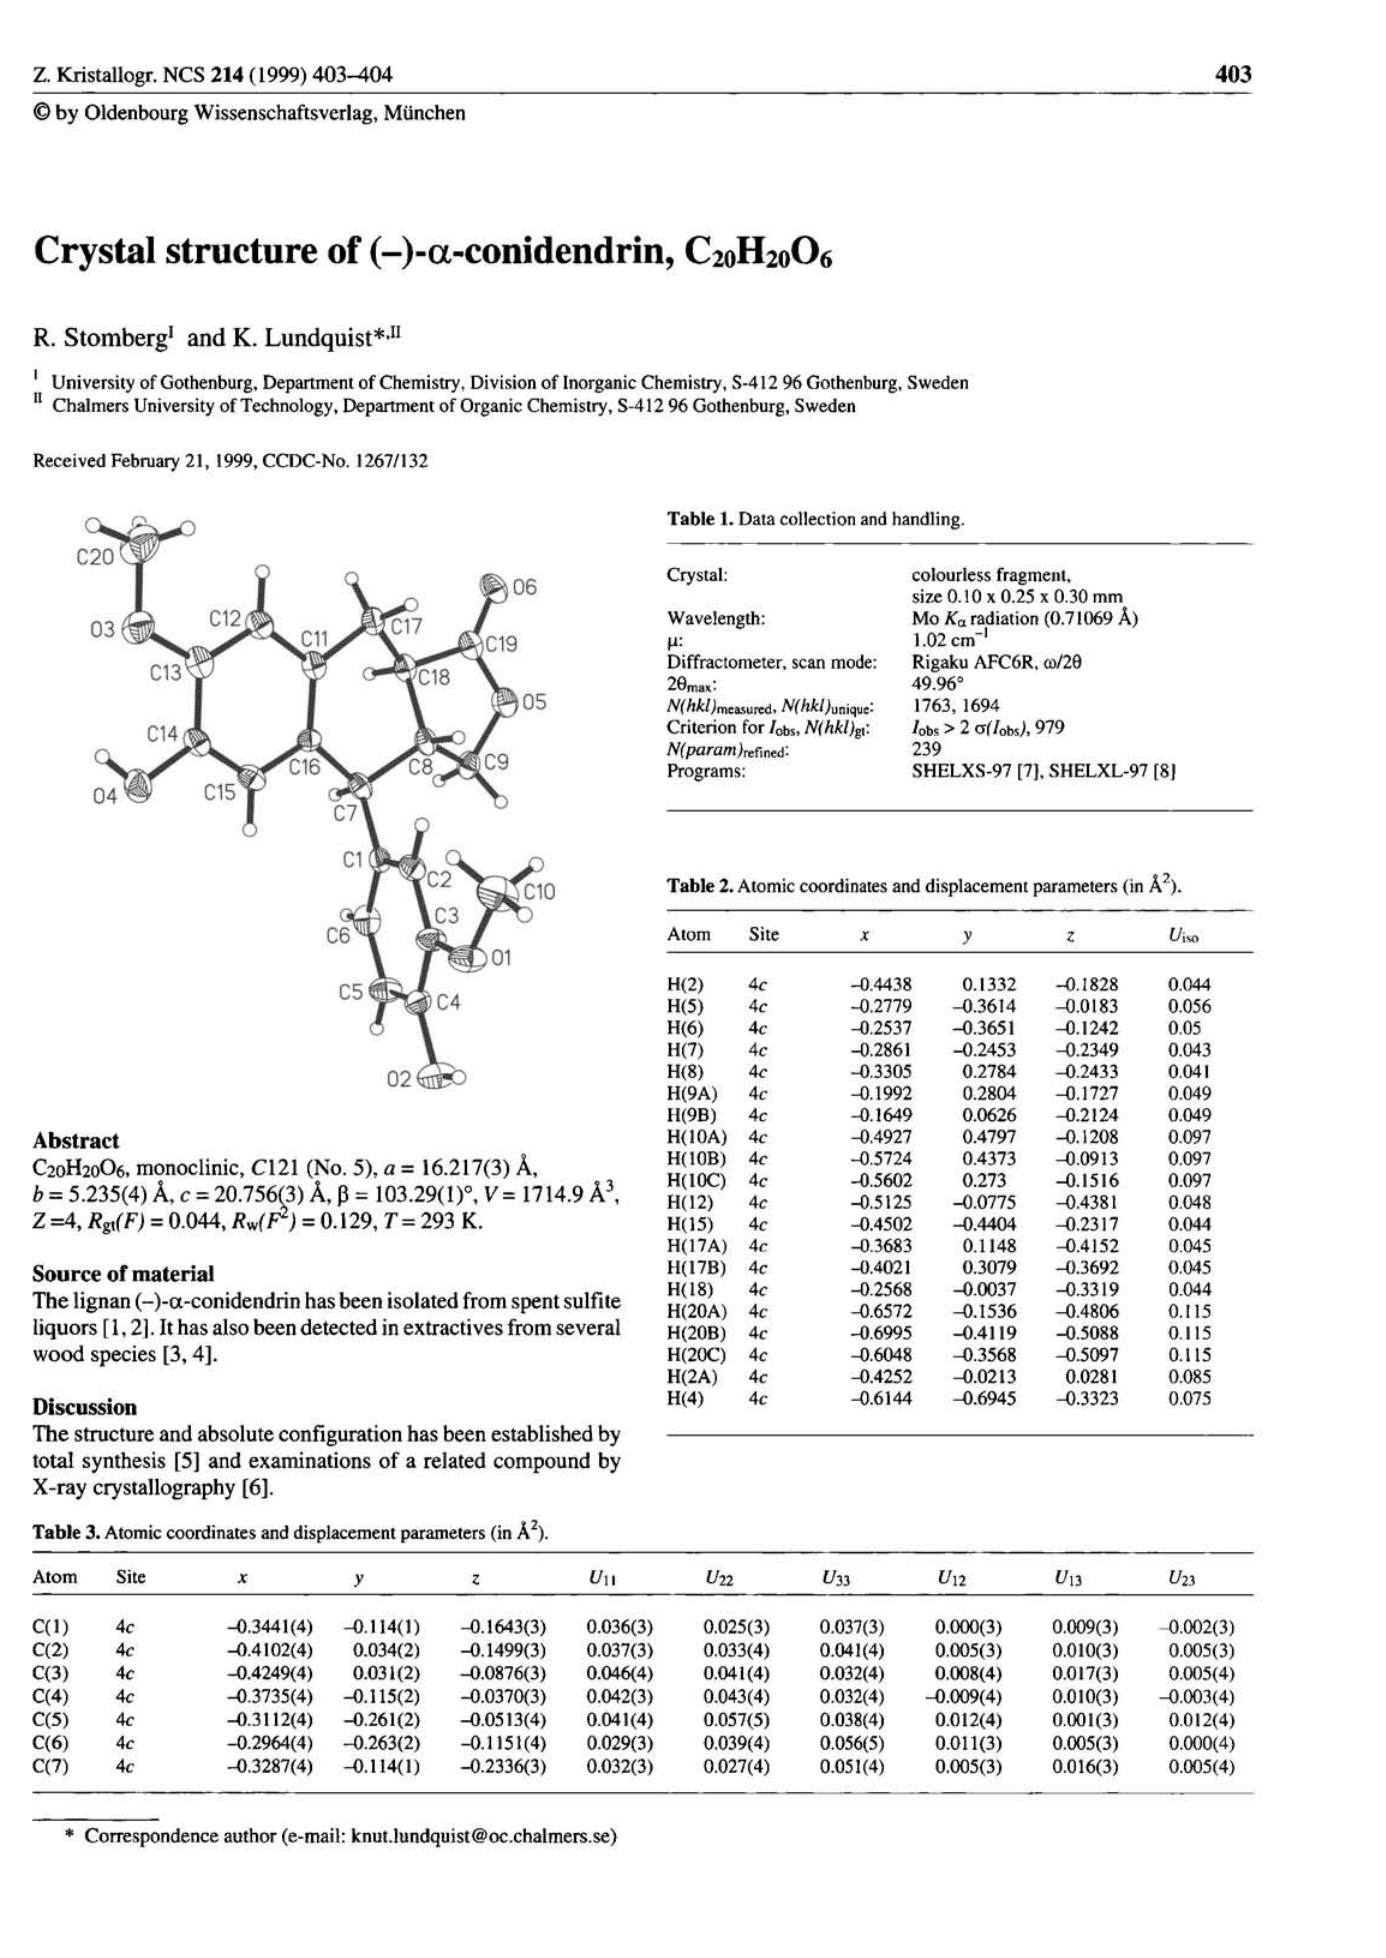
Table 1. Data collection and handling.